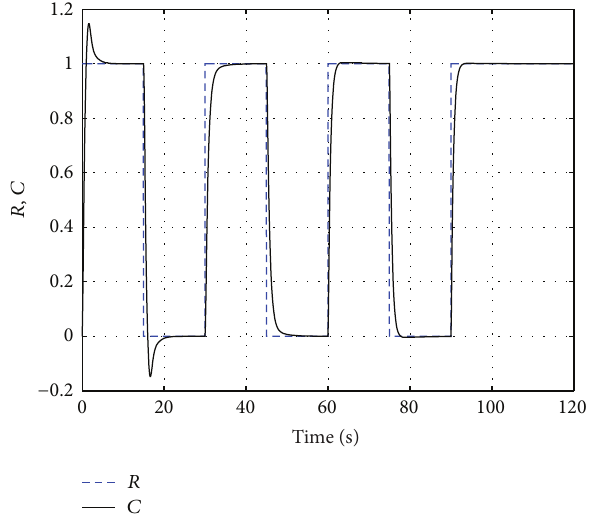
Figure 8: Online automatic tuning process of the illustrating example for matching peak point and rise time specification.